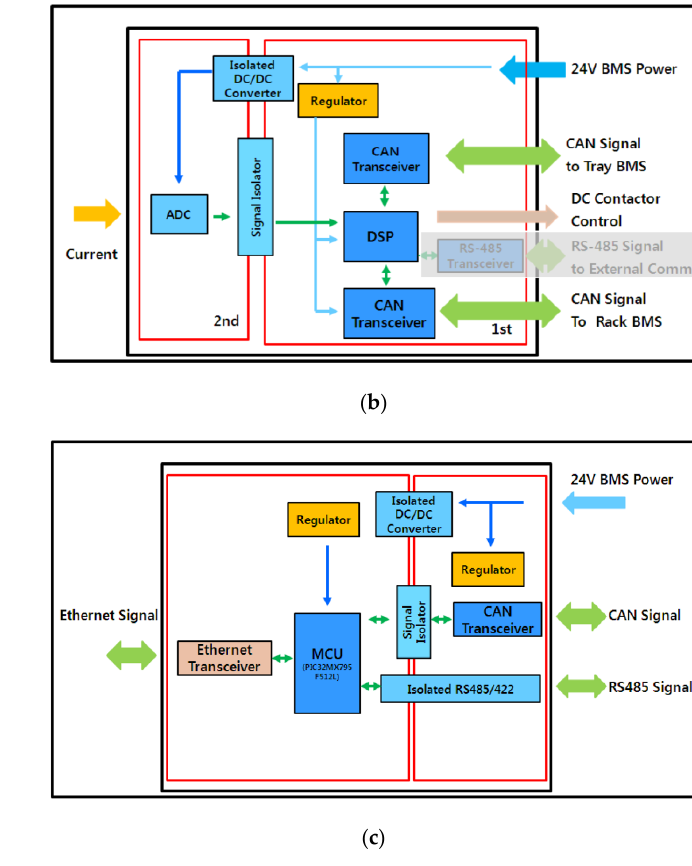
Figure 4. Battery management system (BMS) configuration and specification: ( a ) Tray BMS, ( b ) rack BMS and ( c ) system BMS. Table 1. Specifications by Battery Configuration.